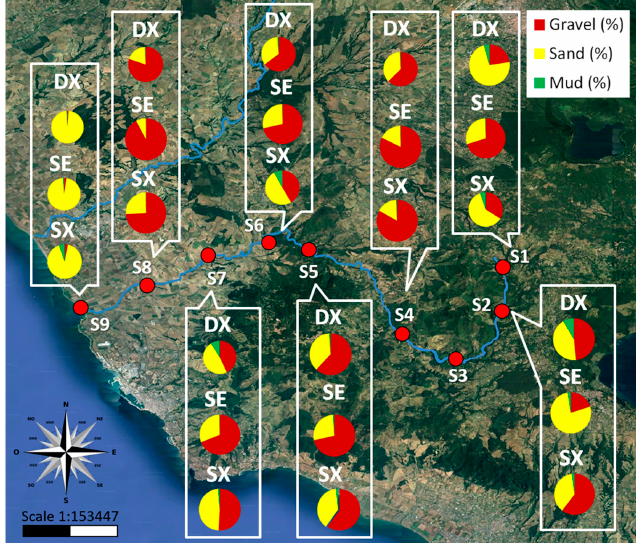
Figure 5. Frequency of grain size sediment for each station divided for riverbed (SE), left riverbank (SX) and right riverbank (DX). Gravel: particles > 2 mm, sand: 0.063 mm < particles < 2 mm, mud: particles < 0.063